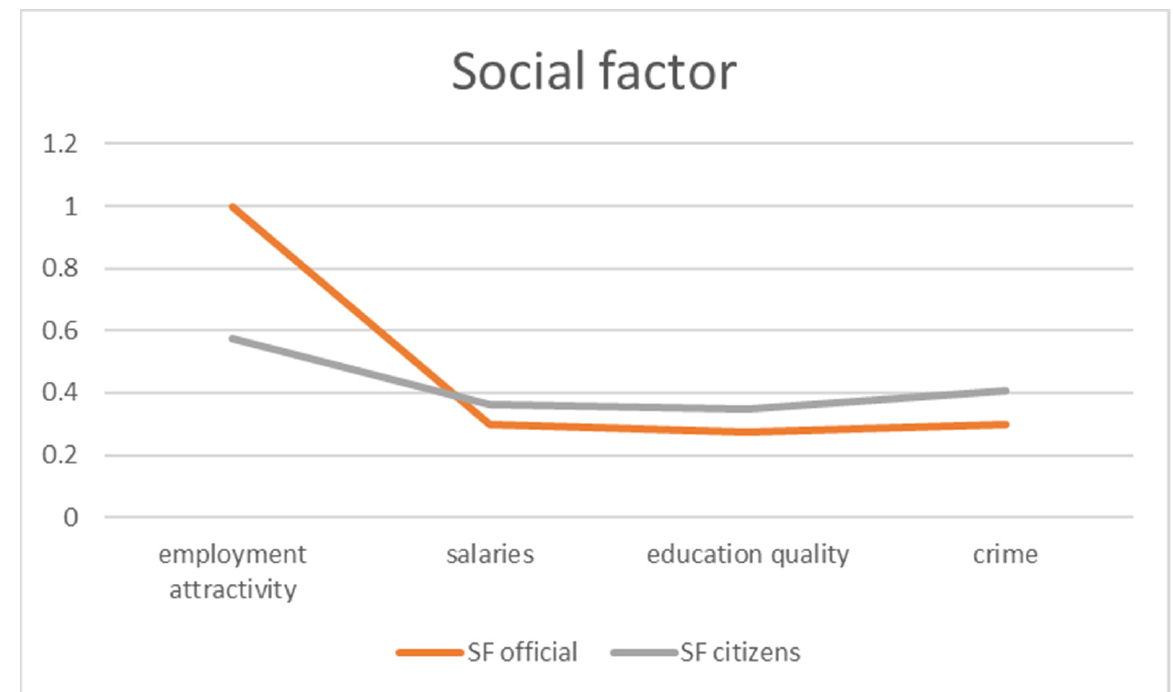
Figure 7. Analysis of economic activities by calculating the coefficient of the supportability factor.